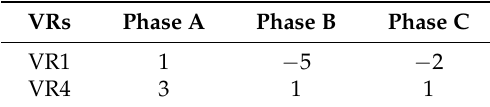
Table 1. References for Reactive Power Controllers.